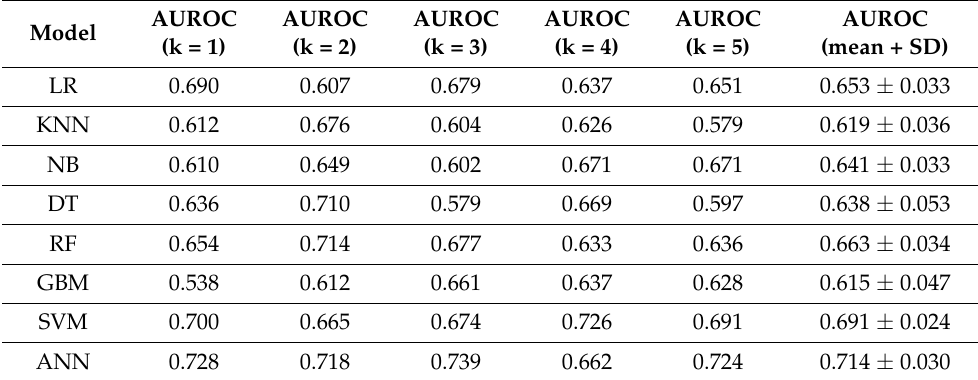
Figure 3. Areas under the receiver operating curve for test data. Table 3. Nested cross validation results of all machine learning